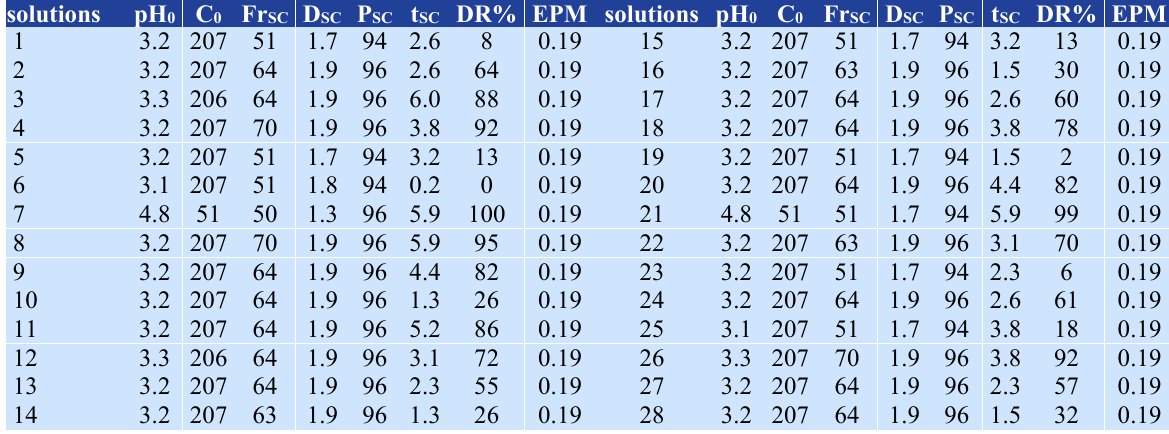
Table 2. Variables values corresponding to each of the Pareto-optimal solution